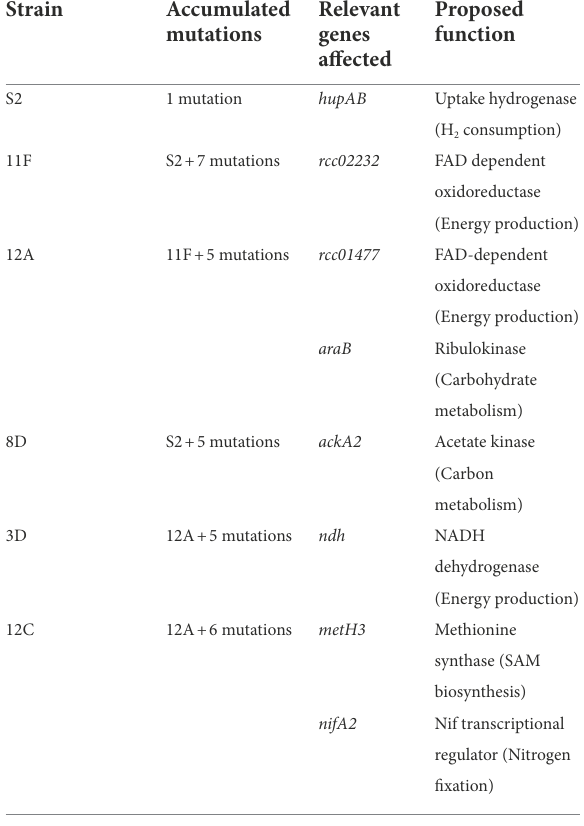
TABLE 1 Mutations accumulated in Rhodobacter capsulatus H 2 overproducing strains.